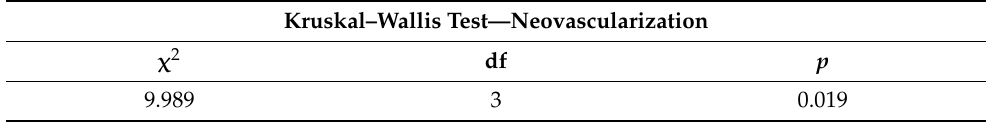
Table 11. Kruskal-Wallis test for the variable “neovascularization”.